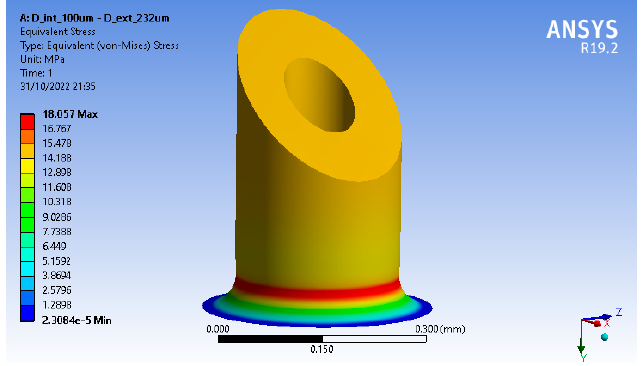
Figure 5. Von Misses Tensions of microneedle.